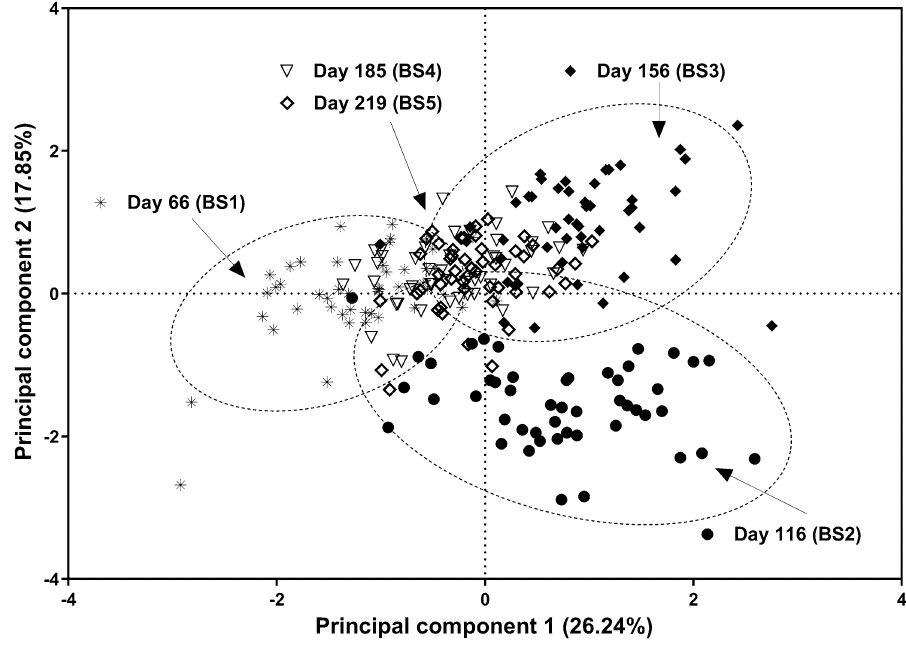
Figure 2. Score plot from principal component analysis of 27 blood metabolites of grazing beef cattle.